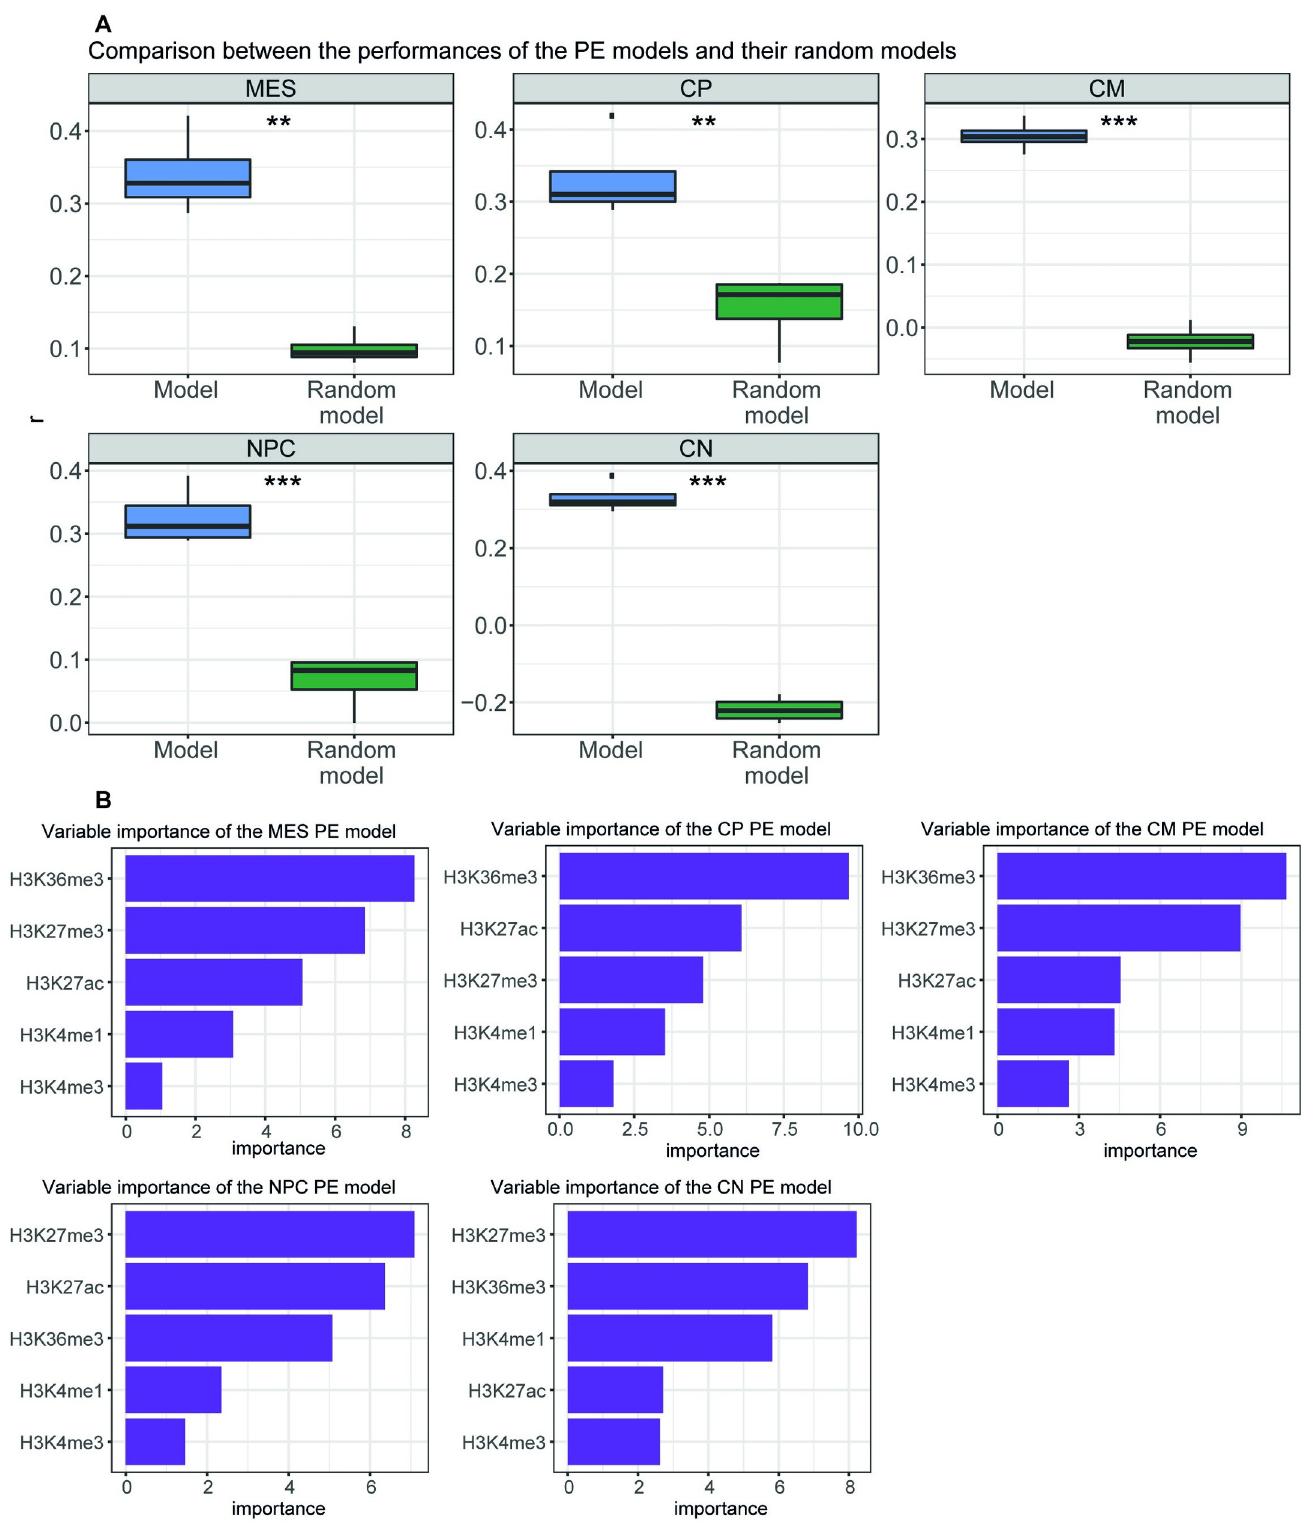
Fig 4. PE models trained in differentiation time points. (A) Performance of each differentiation enhancer model on the rest of the differentiation time points as compared to performance over random models. Performance is represented as Pearson’s correlation ( r ) between predicted expression and measured expression.